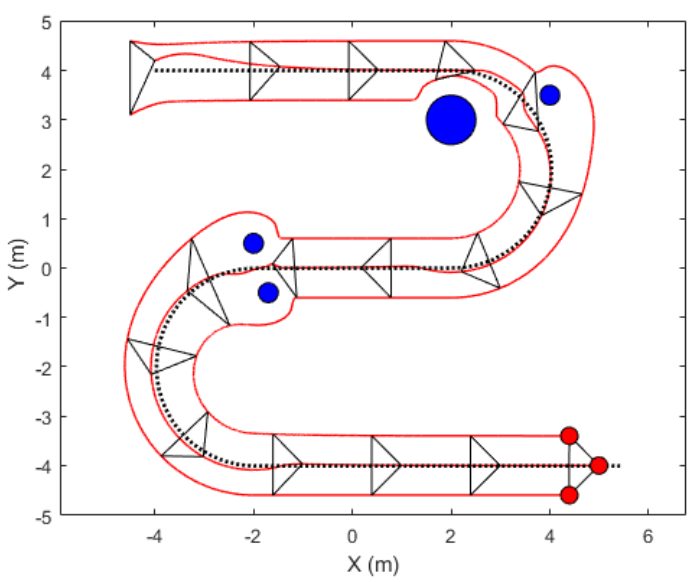
Figure 16. The formation tracking performance for three robots.